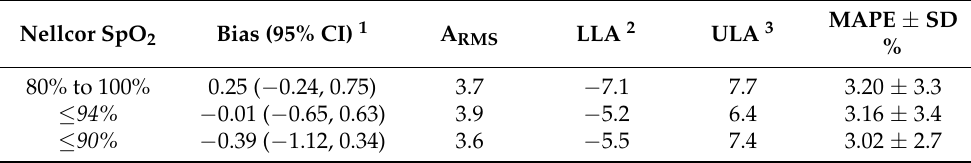
Table 4. Heart rate (bpm). Mean error (bias), accuracy (A RMS ), and mean absolute percent error (MAPE) of the BrOxy M, in the whole sample and in subjects with defined desaturation. Data are reported in percent.